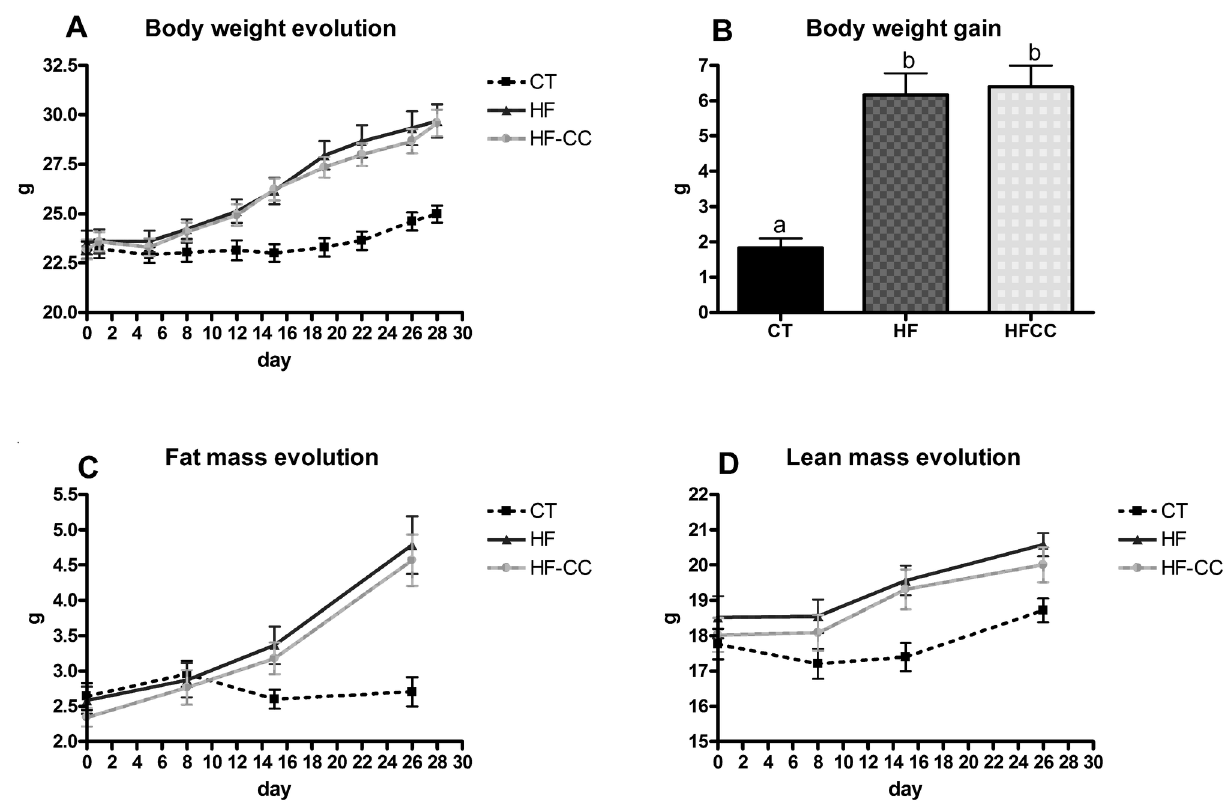
Figure 1. Body weight and body composition. Body weight evolution (A), body weight gain (B), fat mass evolution (C) and lean mass evolution (D) of mice fed a control diet (CT), a high fat diet (HF) or a high fat diet supplemented with Curcuma-P® (HF-CC) for 4 weeks. Data with different superscript letters are significantly different at p<0.05, according to the post hoc ANOVA statistical